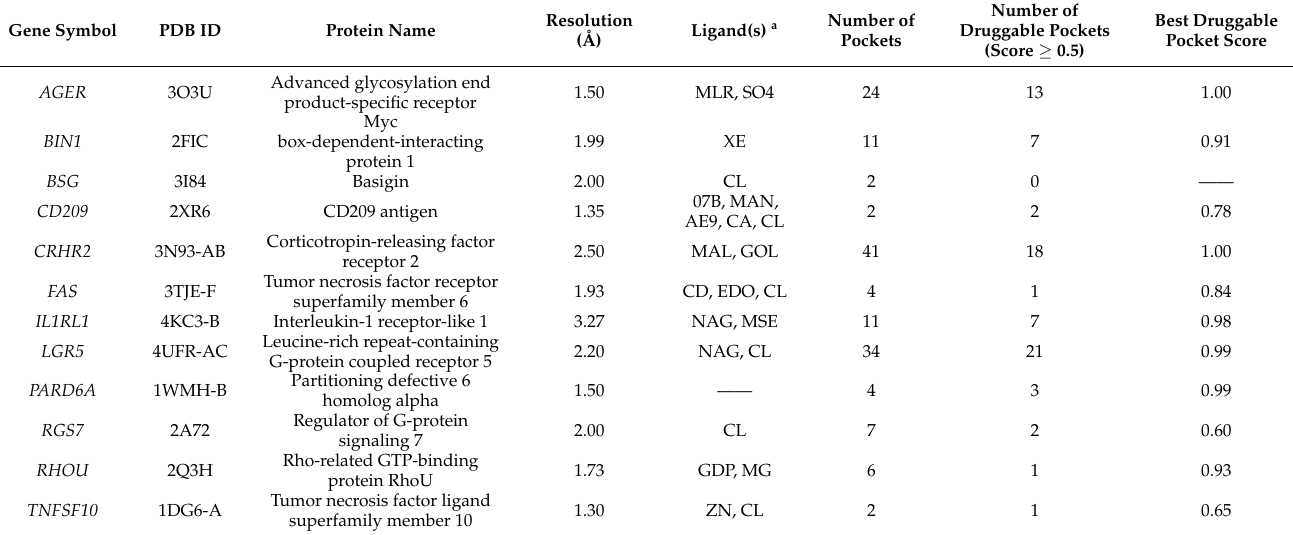
Table 4. Druggability information of candidate